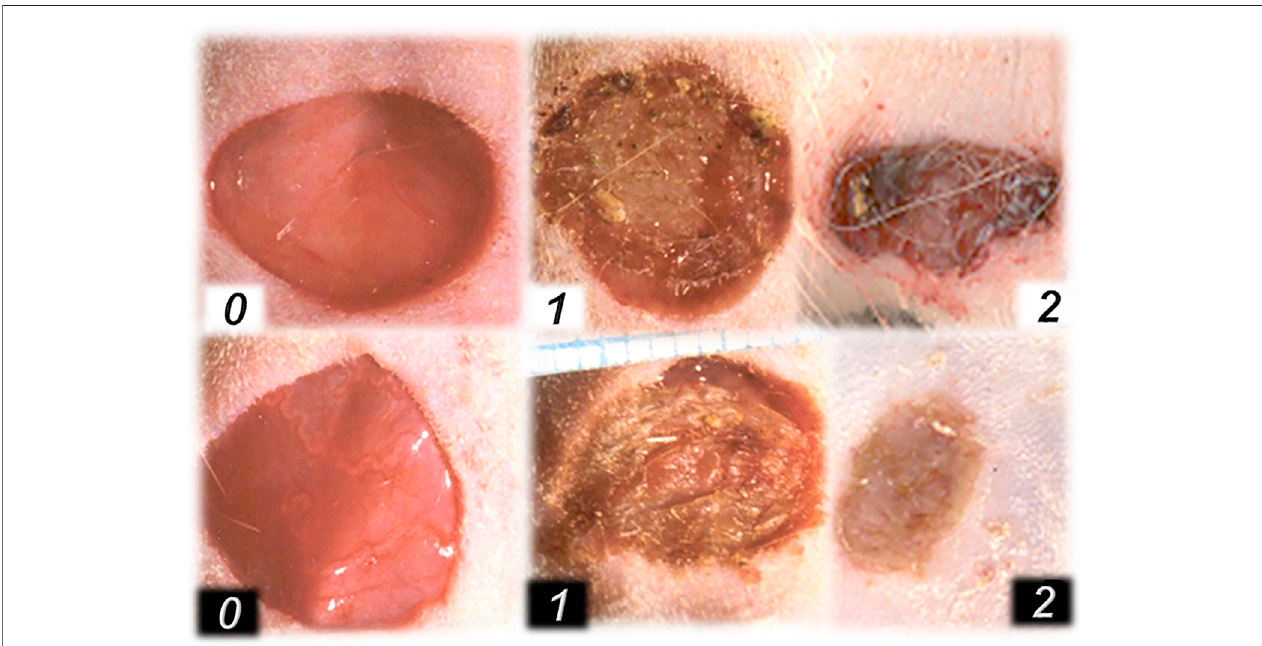
FIGURE 2 | Excisional wound in diabetic rats (0, 1) and in rats with ligation of the right iliac artery and vein (2) (upper) and BPC 157 therapy (lower) . At 3 days before wounding, alloxan (300 mg/kg sc), thin layer of the BPC 157 cream (1 µg/1 g neutral cream) (white number), or neutral cream (black number) was immediately givenuponwounding( 0,0 ).Advancedwoundhealingpresentationat24 hinBPC157rats( 1,white ),butnotincontrols( 1,black ).Likewise,advancedhealingintherats with ligated right iliac arteries and veins, when ingested BPC 157 through drinking water (10 μ g/kg, 10 ng/kg, 0.16 μ g/ml, 0.16 ng/ml, and 12 ml/rat/day) at postsurgery day 4 ( 2, white ), but not in controls ( 2, black